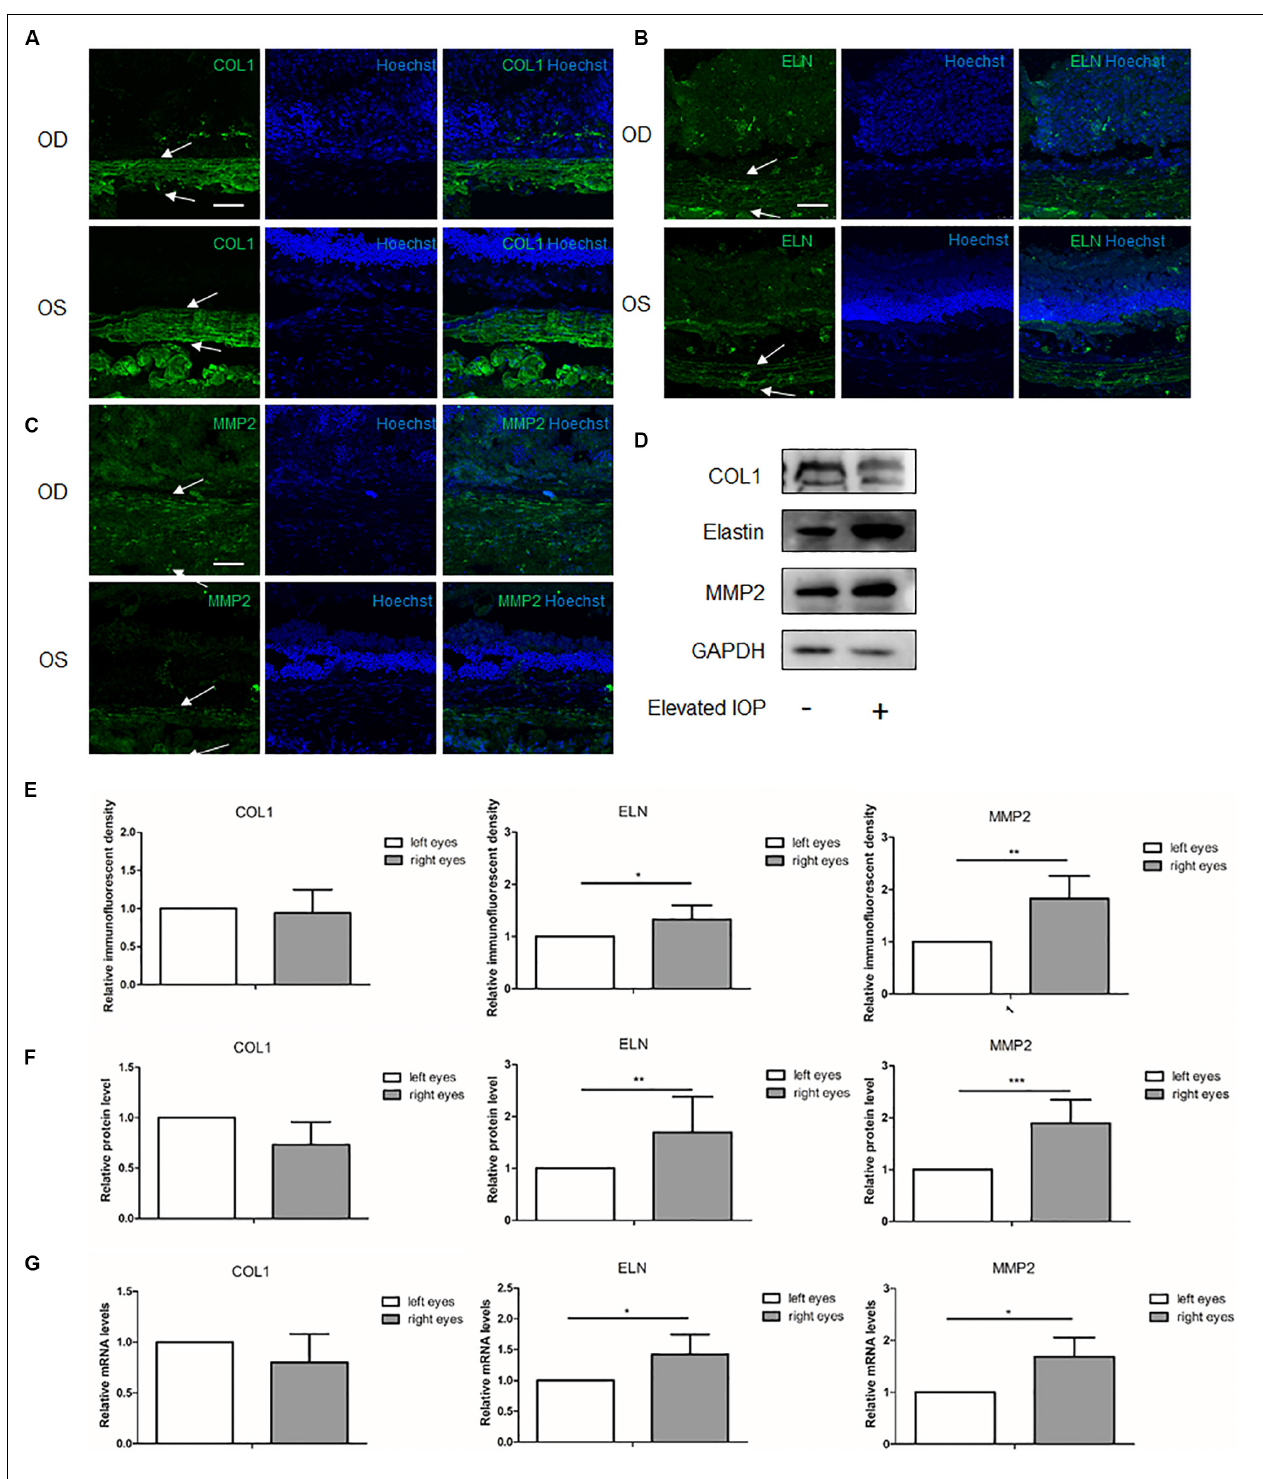
FIGURE 3 | Expressions of the scleral extracellular matrix (ECM) components under chronic elevated intraocular pressure (IOP) for 2 weeks. The ocular hypertension model was established for 2 weeks in rats. Immunohistochemical staining showed the scleral (A) collagen I ( green ), (B) elastin ( green ), and (C) matrix metalloproteinase 2 (MMP2, green ) expressions in the hypertensive right eyes ( OD ) and the contralateral left eyes ( OS ). (E) Semi-quantitative analysis ( n = 7). White arrows indicate the sclera. Scale bar , 50 µ m. (D) Western blot and (F) the quantification analysis showed the protein expressions of collagen I, elastin, and MMP2 ( n = 11). (G) mRNA expressions of collagen I, elastin, and MMP2 ( n = 7). GAPDH was set as the loading control. Data were expressed as the mean ± SD of three replicates. * P < 0.05; **0.001 < P < 0.01; and *** P < 0.001.